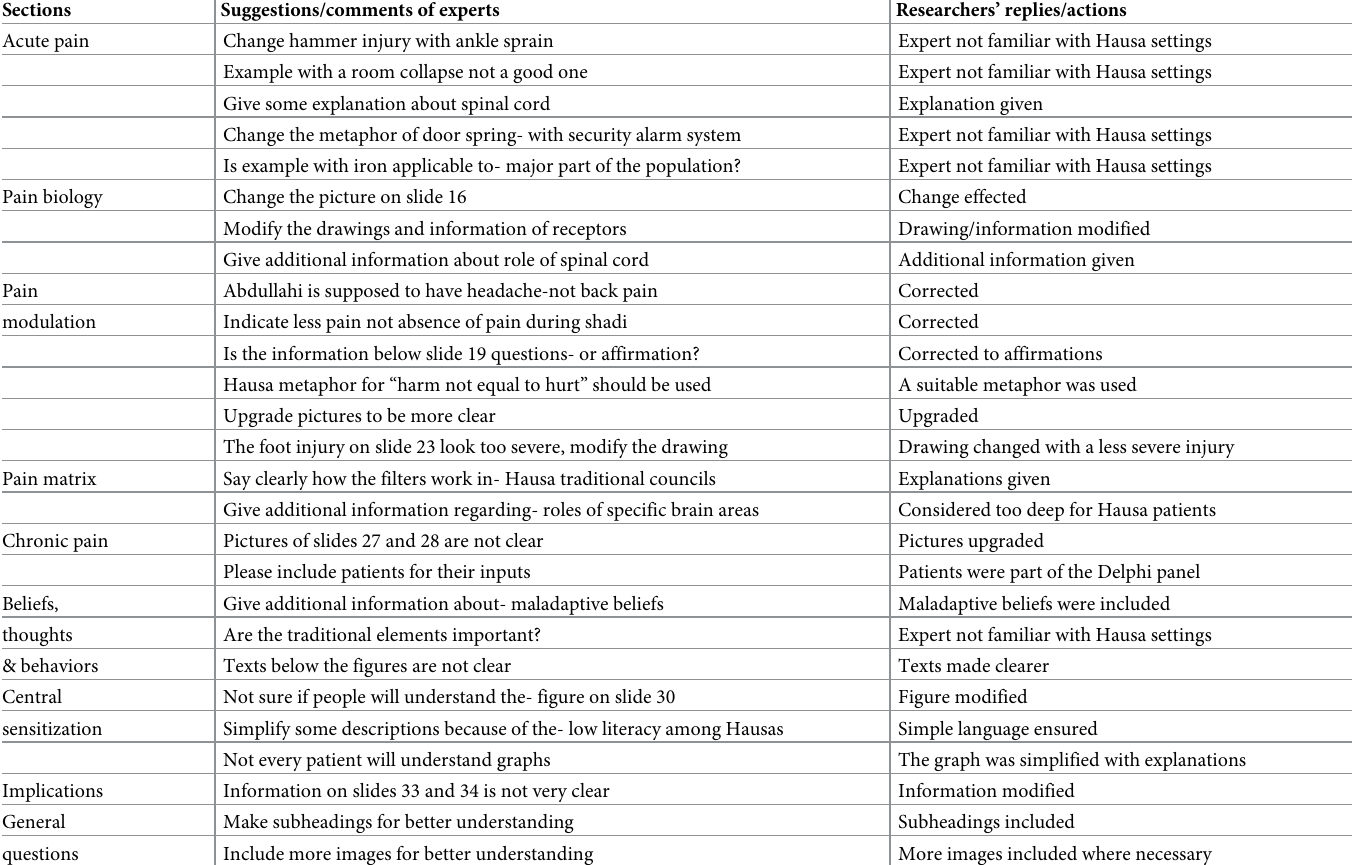
Table 3. Experts’ responses to open-ended questions for the Delphi round 1 (for male and female teaching materials) (n = 19).